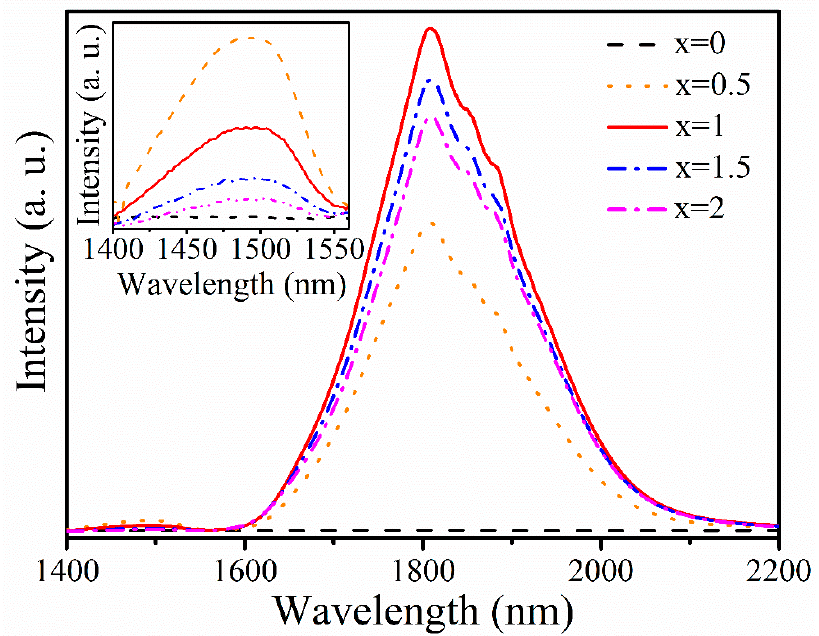
Figure 2. Fluorescence spectra of TGBT-x glasses under excitation at 800 nm laser diode (LD). The inset presents emission spectra in the range from 1400 nm to 1560 nm.